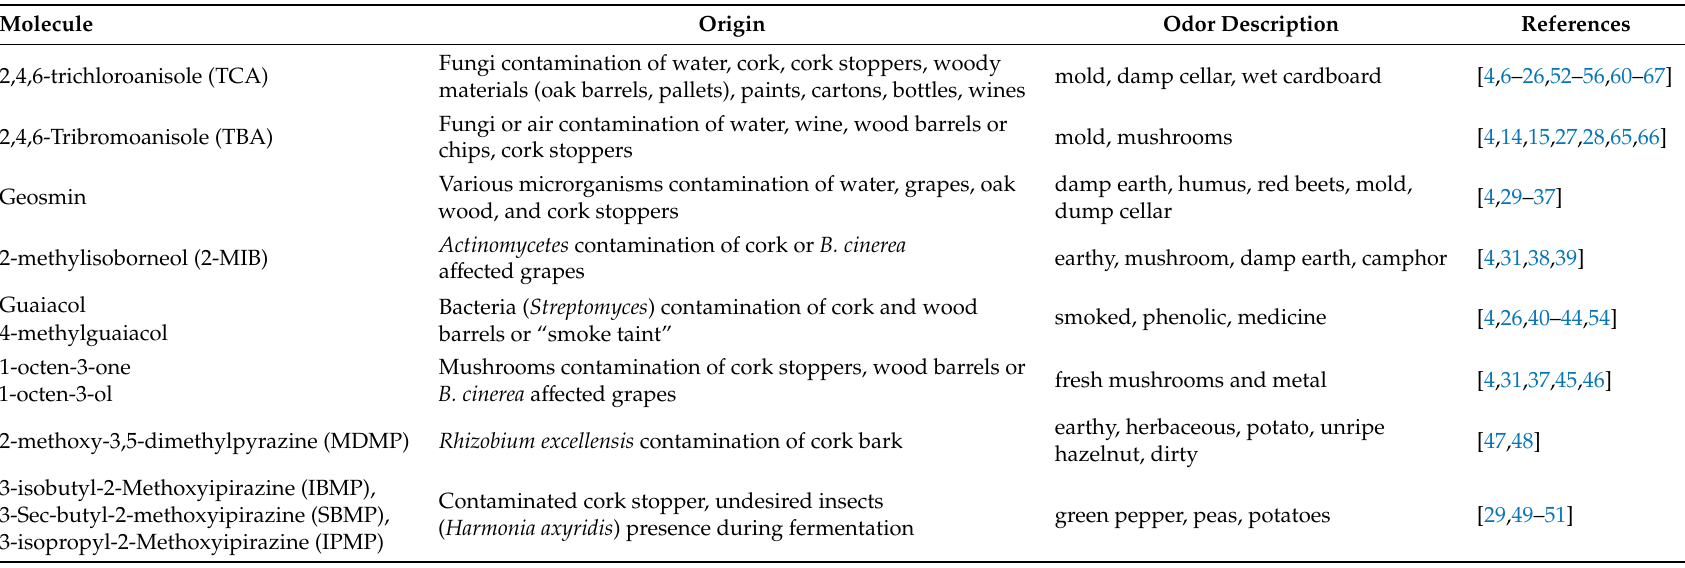
Table 1. The molecules involved in the so called “cork taint” and the references cited in this